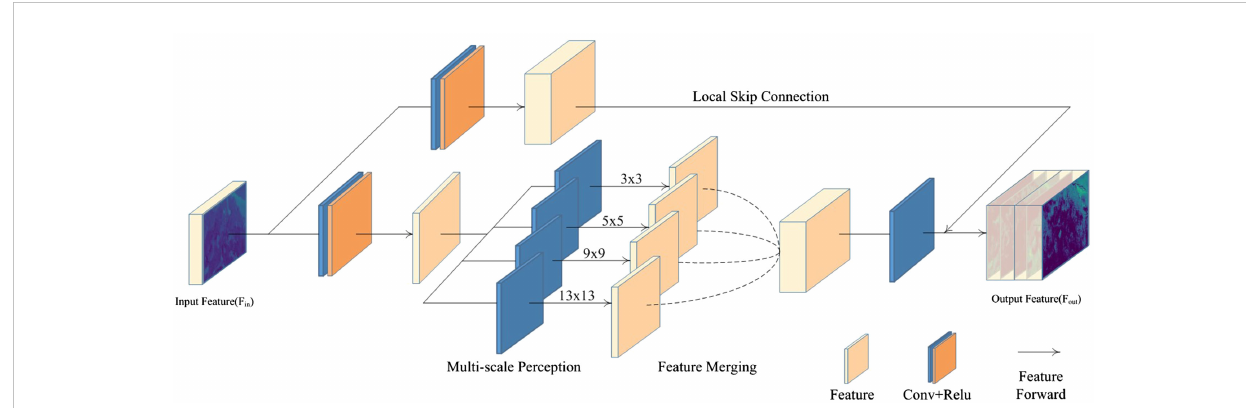
FIGURE 3 The MRF enhancement block comprises two branches: the high-dimensional extract branch and the multi-scale perception branch. The high- dimensional extract branch is responsible for preserving the high-resolution details of the input features, while the multi-scale perception branch employs convolution kernels of varying sizes to capture multi-scale